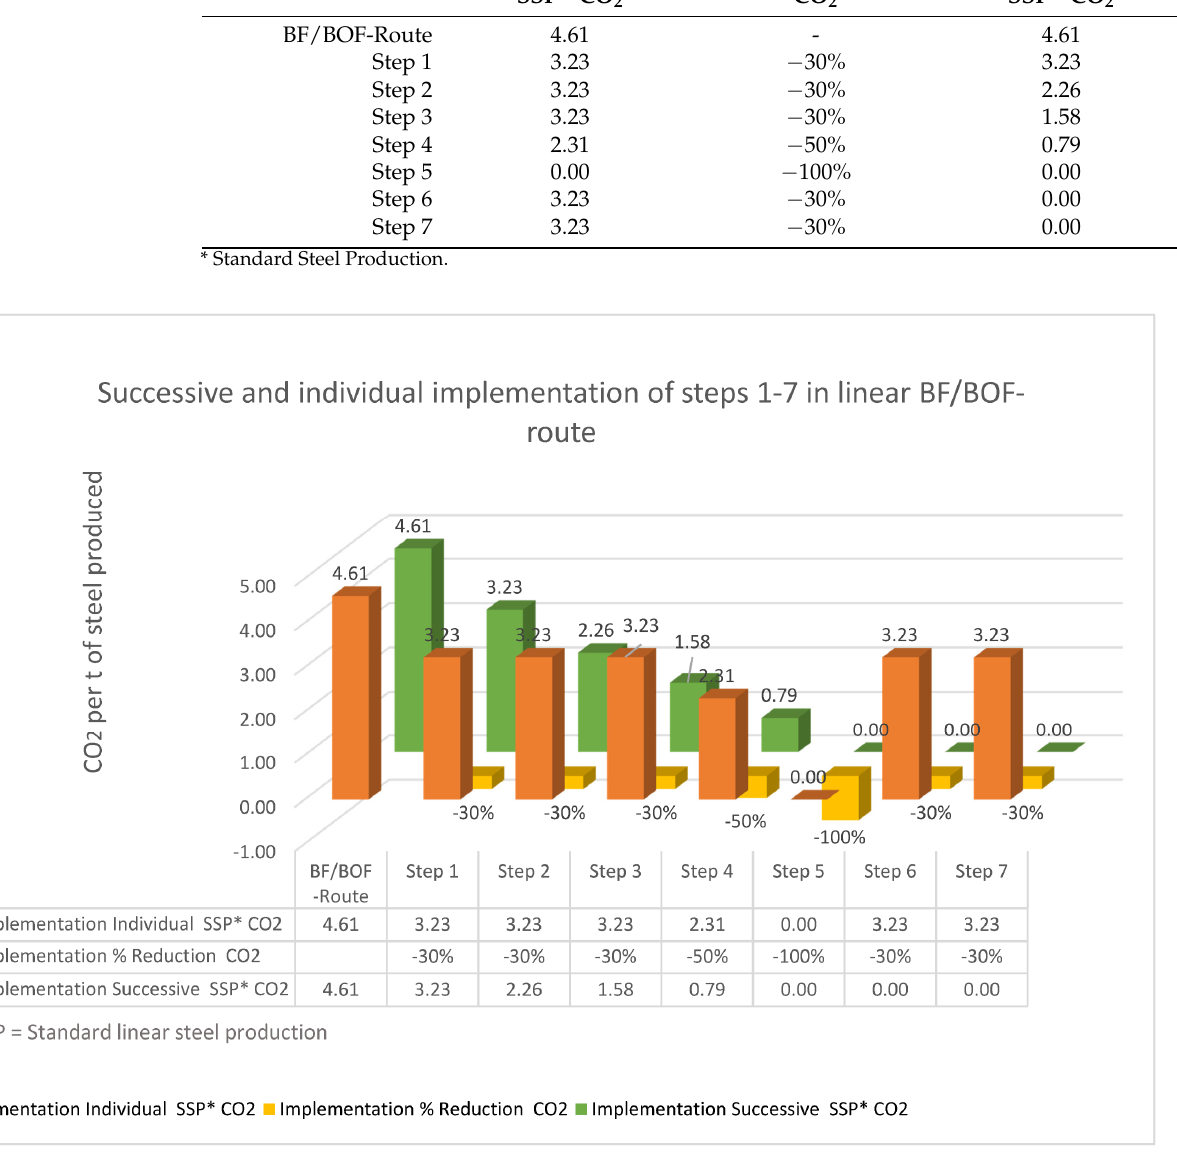
production—already with step 5–100% carbon reduction has been